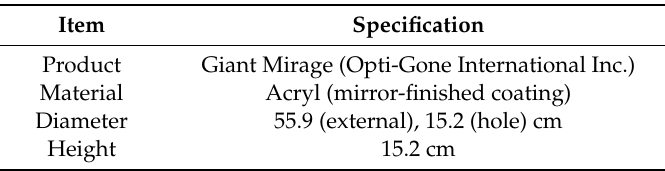
Table 3. Specifications of parabolic mirrors.